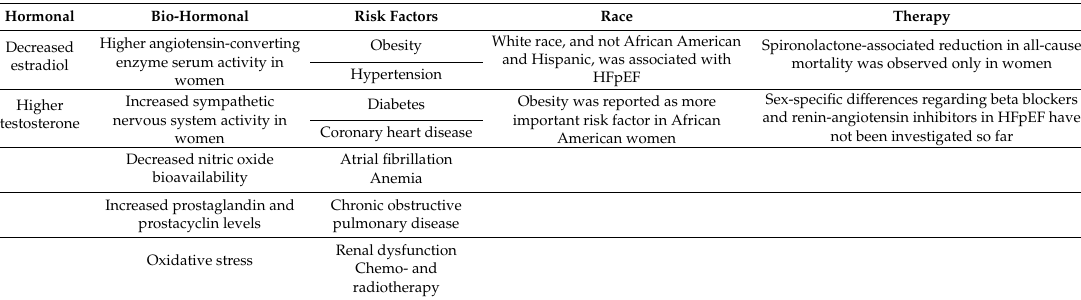
Table 3. Summarized pathophysiology and therapy in women with